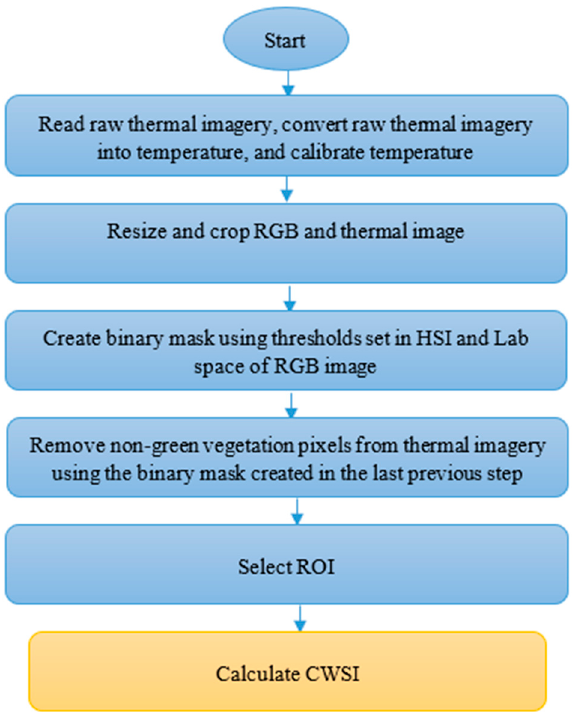
Figure 2. Steps used in analyzing color and thermal imagery for CWSI calculation.